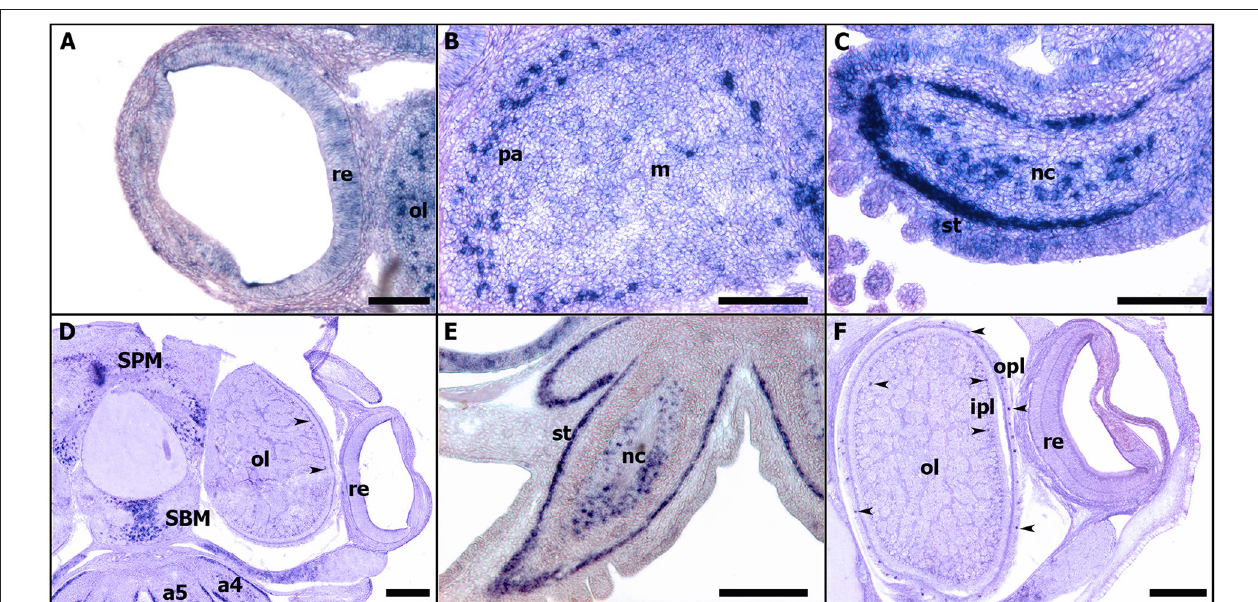
FIGURE 8 | Expressions of Sof-dac during S. officinalis organogenesis on transversal cryo-sections. Dorsal side is up and ventral side is down. (A–C) : stage 24. (A) : eye. (B) : optic lobe. (C) : arm 5. (D,E) : stage 26. (D) : expressions in the supraesophageal and subesophageal masses, in inner and outer plexiform layers (black head arrow) and medullar zone of the optic lobes. (E) : arm 5. (F) : stage 28, optic lobe and eye. Black head arrows point out the expressions of the respective genes in the eyes. a4, a5: arms; ipl: inner plexiform layer; m: medulla; nc: nerve cord; ol: optic lobes; opl: outer plexiform layer; pa: plexiform area; re: retina; SBM: subesophageal mass; SPM: supraesophageal mass; st: surrounding tissue. (A–C) : scale bar is 150 µ m. (D–F) : scale bar is 300 µ